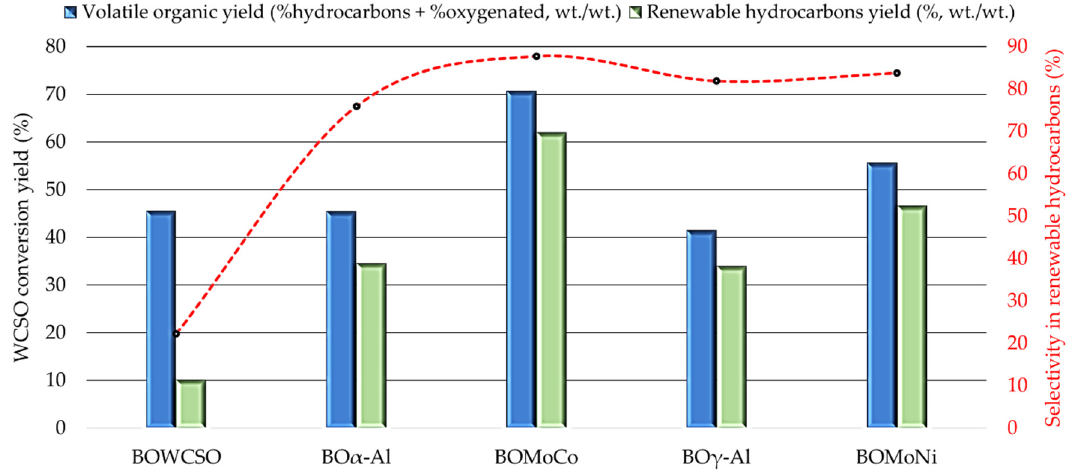
Figure 7. Conversion yields of the WCSO to total volatile organics (%hydrocarbons + %oxygenated) and to renewable hydrocarbons derived from the catalytic and non-catalytic micropyrolysis experiments at 500 °C. Determination performed by GC-FID.